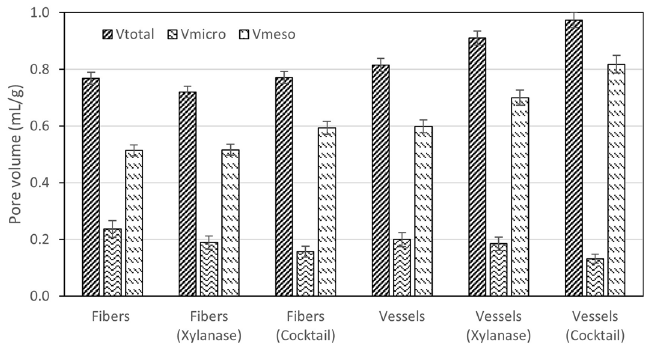
Figure 2. Pore composition volumes for fibers and vessels, treated and